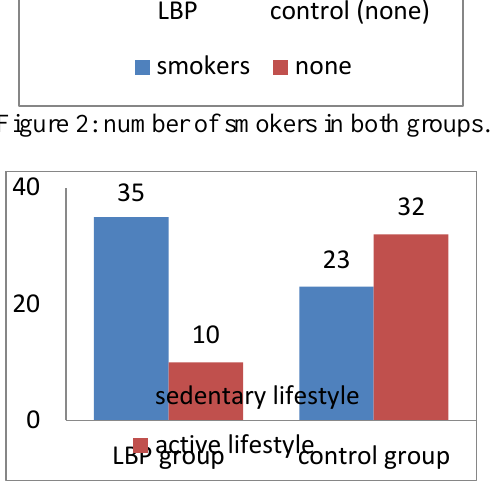
Figure 3: number of participants according to the type of lifestyle in both